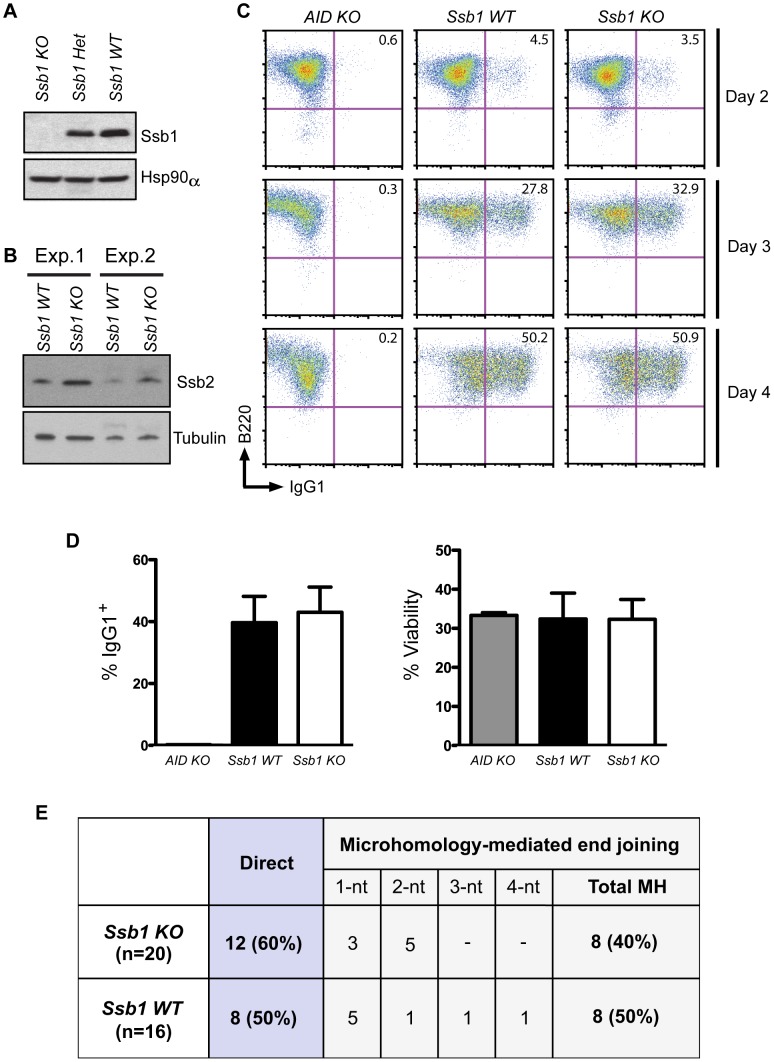
Class switch recombination activity in B-cell specific Ssb1-deleted mice.
Ssb1 fl/fl mice were crossed with a Cd19-Cre transgene expressing C57BL/6J mice to specifically delete Ssb1 in B cells. Splenic B cells were isolated and stimulated for 2, 3, and 4 days using anti-Cd40 antibodies plus IL-4 to induce CSR to IgG1. (A) Western blotting of whole cell extracts showed loss of Ssb1 protein in stimulated B cells from Ssb1 knockout (Ssb1 KO; Cd19Cre+: Ssb1−/−) mice. Equal amounts of stimulated B cell extracts from heterozygous Ssb1 (Ssb1 Het; Cd19Cre+: Ssb1+/−) and wild-type Ssb1 (Ssb1 WT; Cd19Cre+: Ssb1+/+) mice were included for comparison. Equal loading was confirmed by probing for Hsp90α. (B) Western blotting of Ssb2 levels in B cells from Ssb1 WT and Ssb1 KO mice. (C) FACS analysis of CSR to IgG1 over time in stimulated B cells from mice of the indicated genotypes. Stimulated splenic B cells from AID−/− (AID KO) mice served as a negative control. (D) Summary statistics of CSR activity to IgG1 and viability on day 3 of stimulation. Mean and S.E.M. from three independent experiments are shown. No statistically significant differences (two-tailed unpaired t-test) were found. (E) Switch region junction analysis. Sm-Sg1 junctions were amplified from IL4 plus anti-CD40 stimulated primary B cells (day 4) and sequenced. Percentage and total numbers of direct or microhomology-mediated joints are indicated. nt, nucleotides.